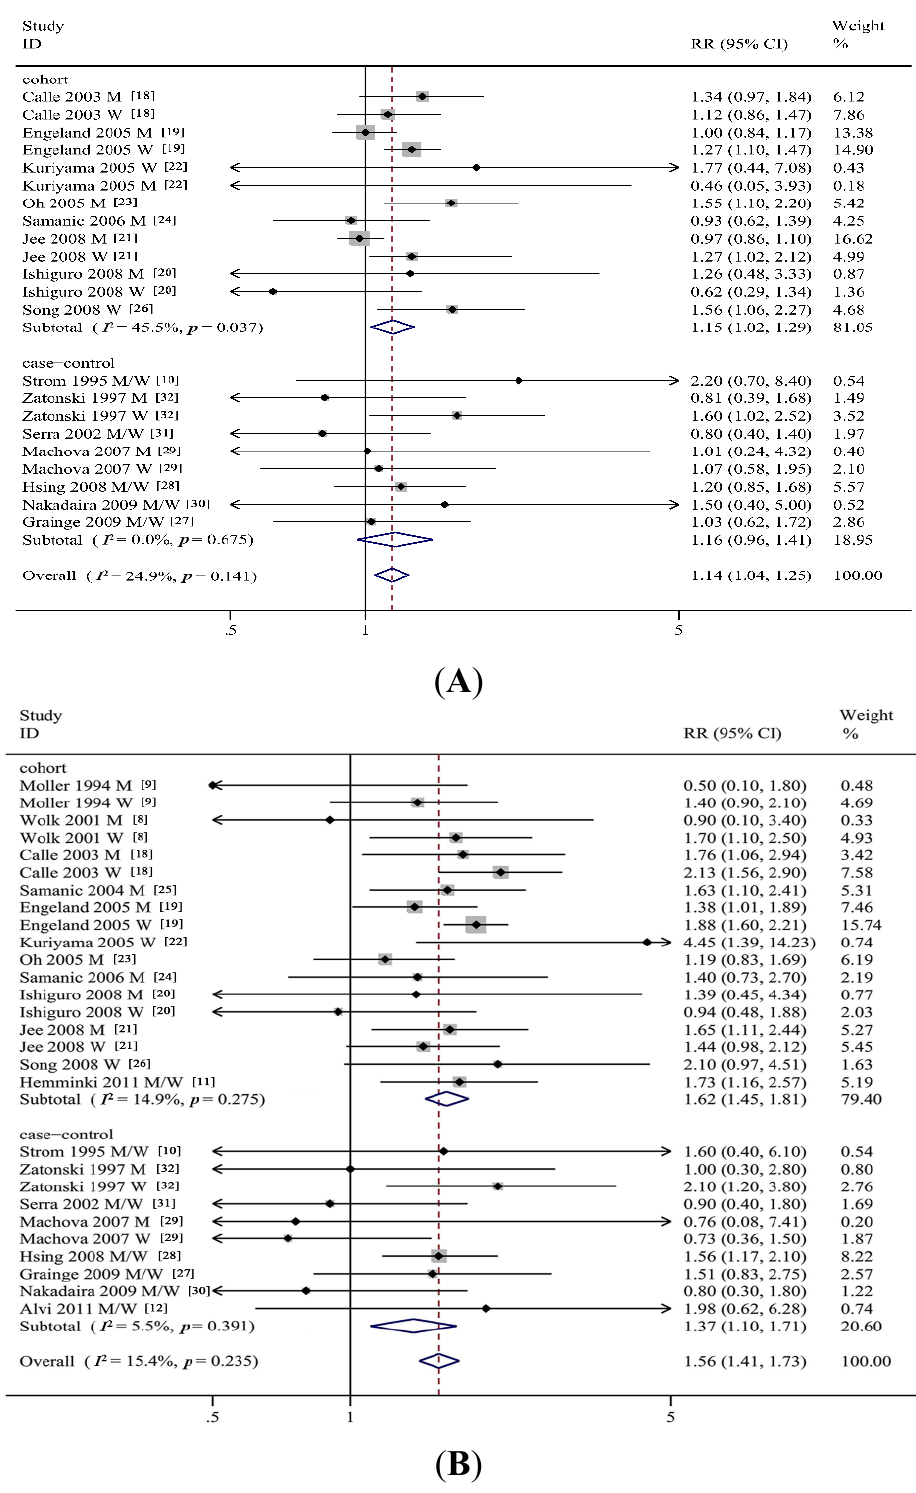
Figure 2. ( A ) Forest plot of risk of gallbladder cancer associated with overweight in general population; ( B ) Forest plot of risk of gallbladder cancer associated with obesity in general population. M, men; W, women; RR, relative risk.